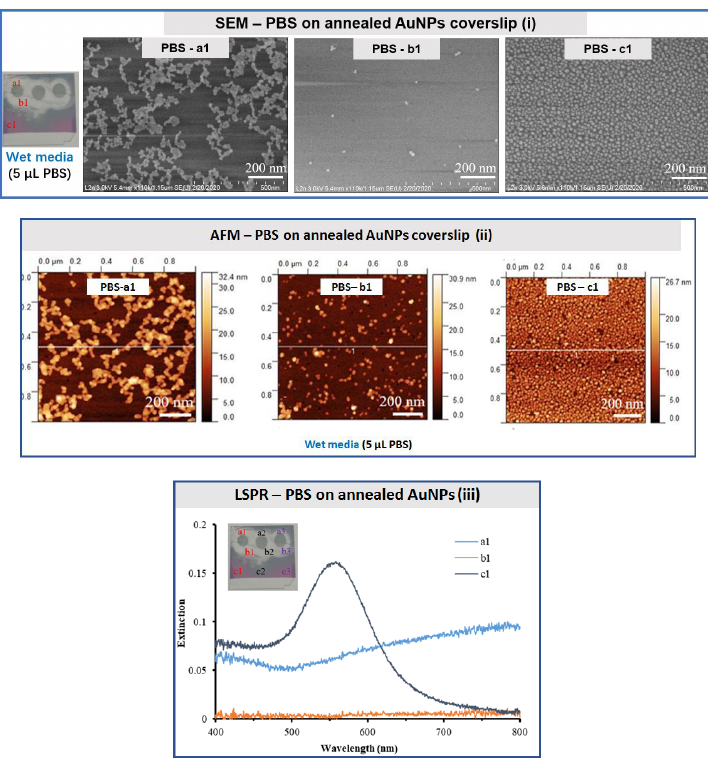
Figure 6. SEM ( i ), AFM ( ii ) and LSPR ( iii ) characterizations of annealed gold nanostructured (AuNPs) coverslips exposed to three drops of PBS (5 µ L) per coverslip under wet media with three areas investigated for each deposited / removed drop: a1, under the drop, b1, in the vicinity of the drop, and c1, far from the drop (10 × PBS bu ff er, pH = 7.4). The SEM, AFM and LSPR measurements were performed under cleanroom conditions at 21 ◦